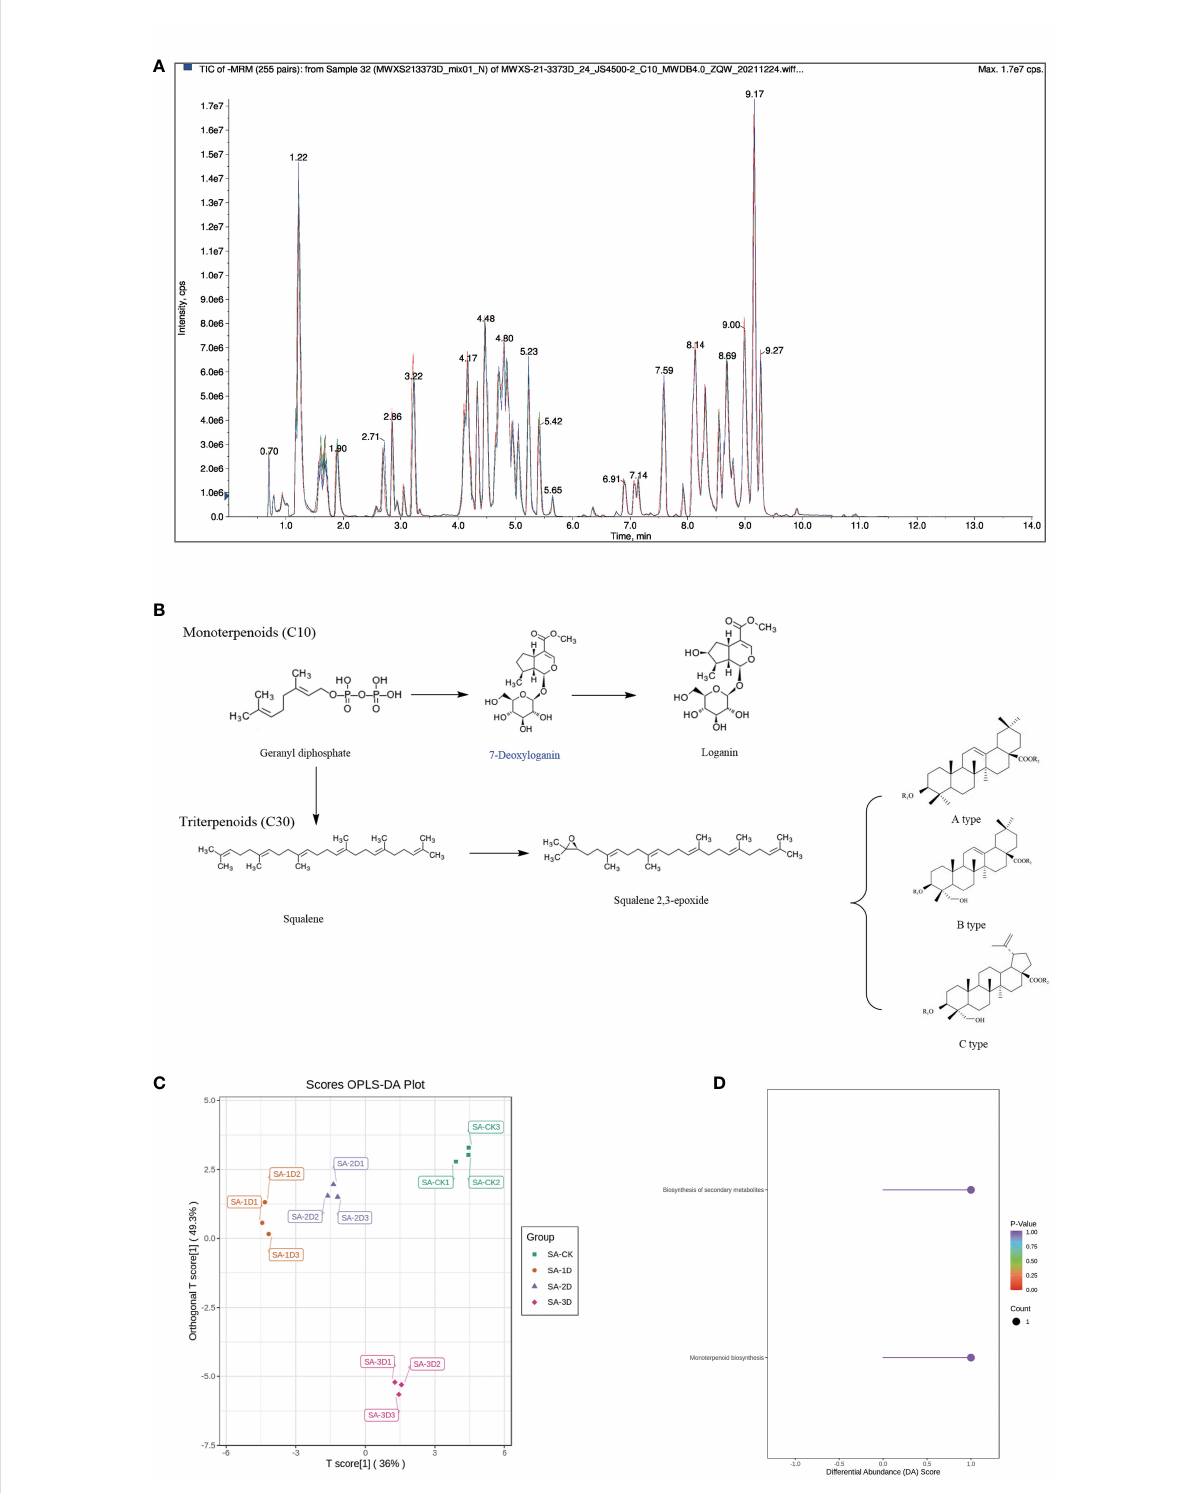
FIGURE 6 Terpenoid DAMs Analysis. (A) QC sample mass spectrometry detection TIC overlay; (B) DAMs involved in triterpene synthesis pathway; (C) Metabolic analysis using OPLS-DA; (D) KEGG enrichment analysis of